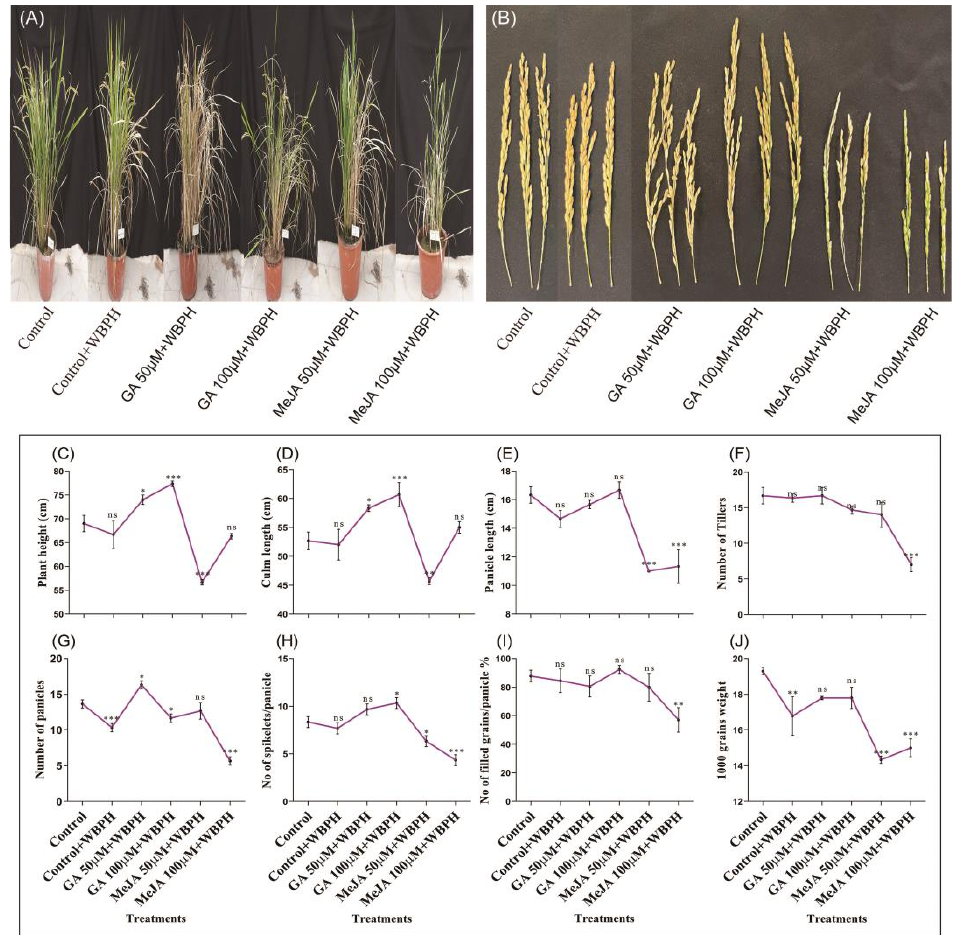
Figure 1. Agronomic traits of the plants at the mature stage receiving different treatments. ( A ) Pictorial representation of plant height. ( B ) Pictorial representation of panicle length. ( C ) Plant height. ( D ) Culm length. ( E ) Panicle length. ( F ) The number of tillers. ( G ) The number of panicles. ( H ) The number of spikelets per panicle. ( I ) The filed grain percentage. ( J ) 1000-grain weight. Each result is the mean of three replicates. The error bars represent the standard error of the mean data ( n = 3); ns represents not significant, and asterisks indicate a significant difference (* p < 0.05, ** p < 0.01, *** p < 0.001), according to the analysis using two-way ANOVA and the Bonferroni post hoc test. The experiments were repeated three times.